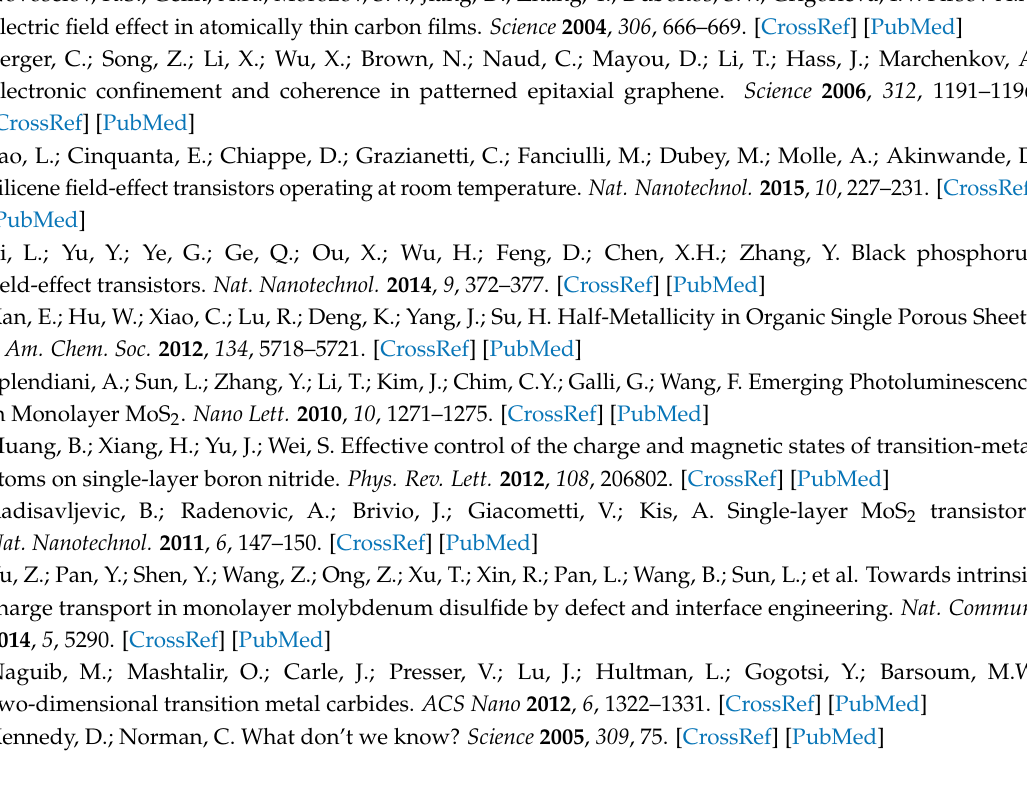
Figure S1: The calculated spin-resolved density of states of 2D SnS monolayer, Figure S2: The calculated binding energy for each TM atom in 2D SnS